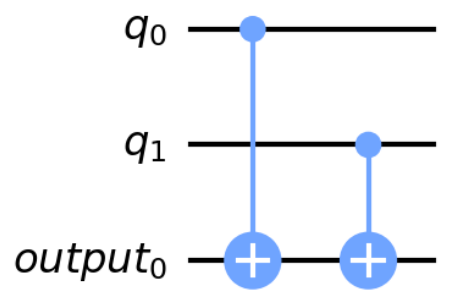
Figure 3. Quantum circuit logic XOR operation.